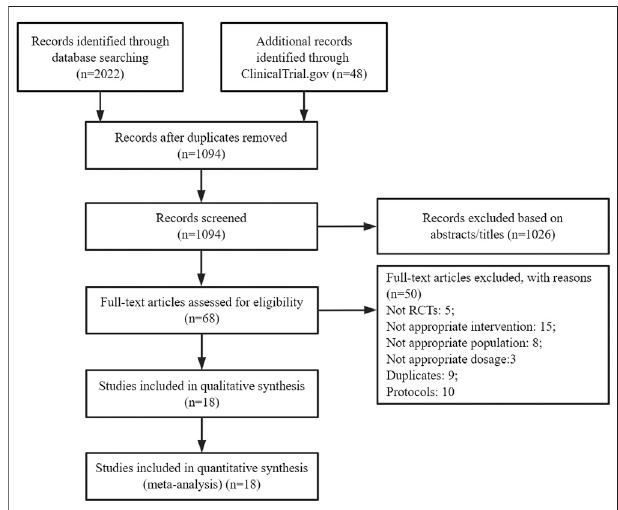
FIGURE 1 | PRISMA fl ow diagram showing the process of study selection. RCT: Randomized controlled